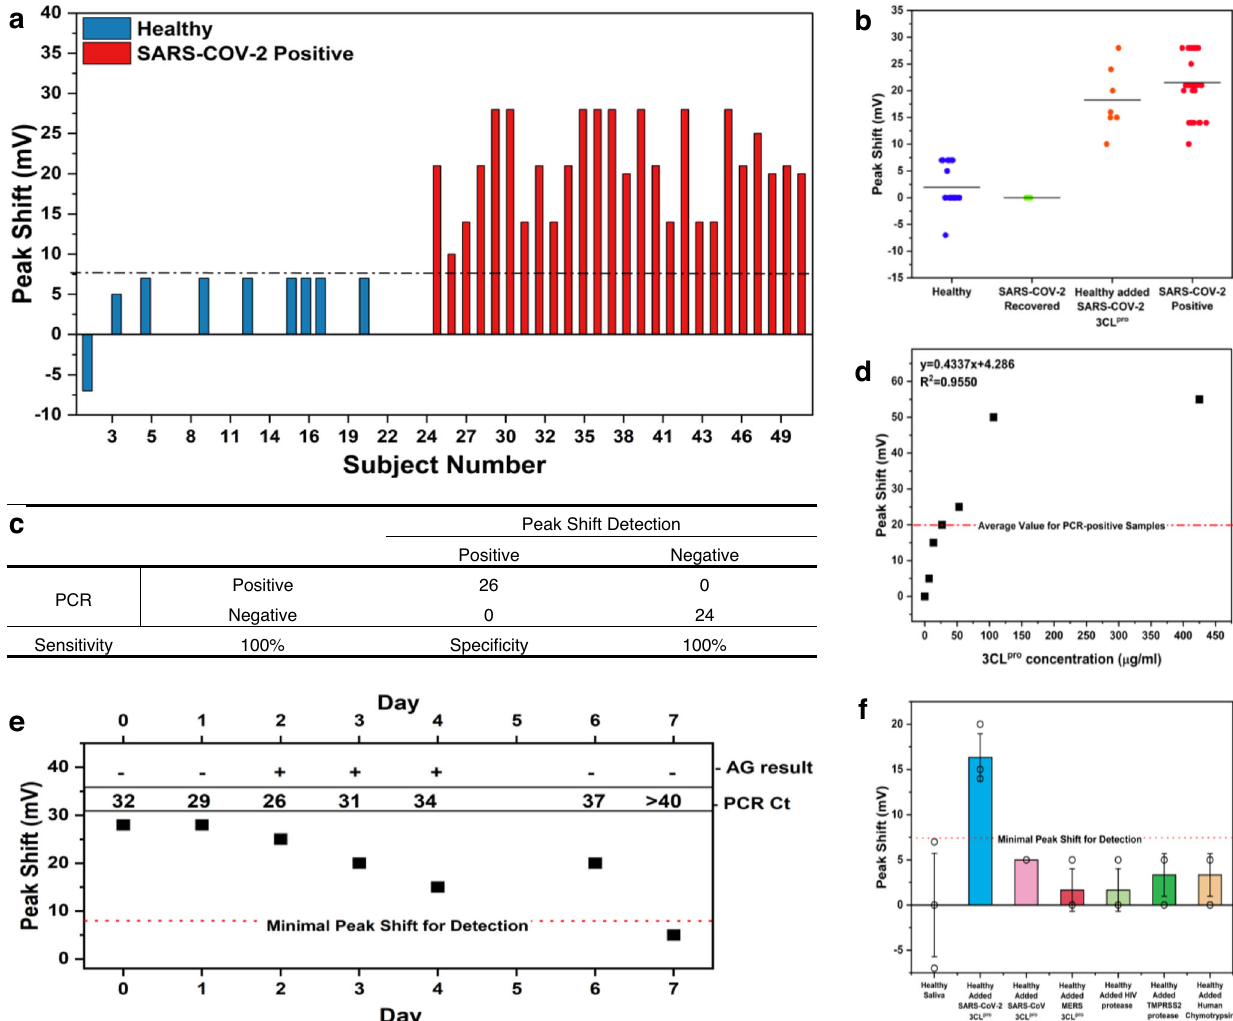
Fig. 5 | SARS-CoV-2 detection in clinical samples. a pBQ oxidation peak shift of healthy (blue) and SARS-CoV-2 PCR-positive (red) saliva samples. b Scatter plot of pBQ oxidation peak shift of SARS-CoV-2 negative saliva (blue, N =24), the saliva of recoveredCOVID-19patients(green, N =4),SARS-CoV-2negativesalivaspikedwith 3CL pro (orange, N =7), and PCR-positive SARS-CoV-2 (red, N =26) saliva samples.